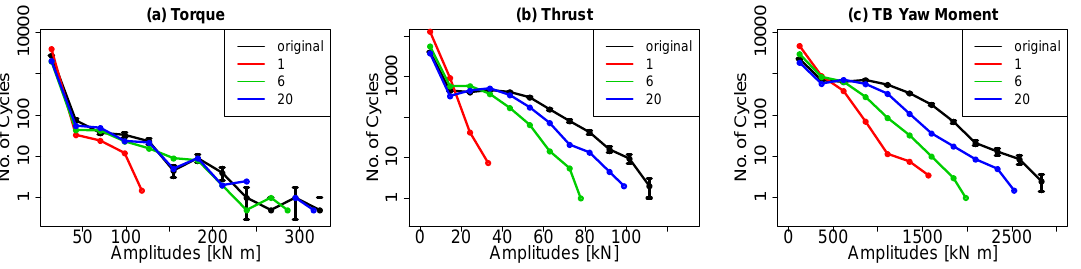
Figure 12. Rainflow counting histograms (RFCs) of different load time series for original LES and truncated PODs including different numbers of modes. To get an impression of the estimation error, the standard error shown for the original LES is estimated by in bin i